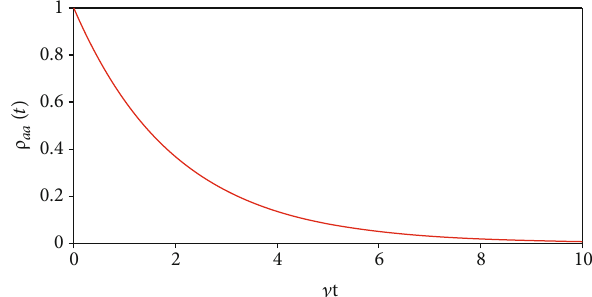
Figure 2: Normalized power spectrum for the atomic variables when the two-level atom interacting with a squeezed vacuum [Eq. (53)].